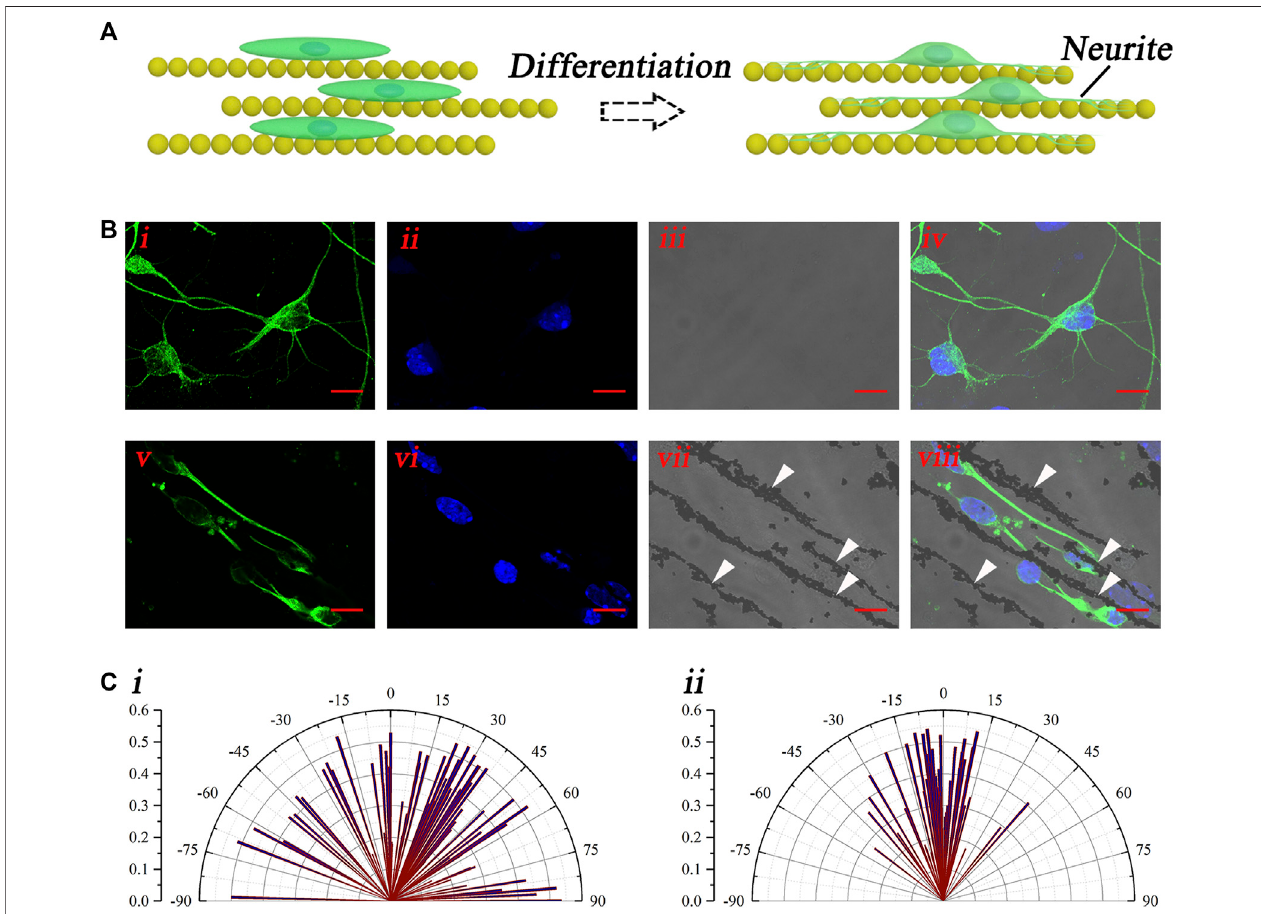
FIGURE 4 | Oriented growth of the newly derived neurons. (A) Schematic illustration of the oriented growth of newly derived neurons. (B) Representative fl uorescent photographs of newly derived neurons of both the control (i – iv) and the nanochain-guided (v – viii) groups, the scale bars are 10 μ m. (C) Orientation angle statistic graphs of both the control (i) and the nanochain-guided (ii) newly derived neurons.